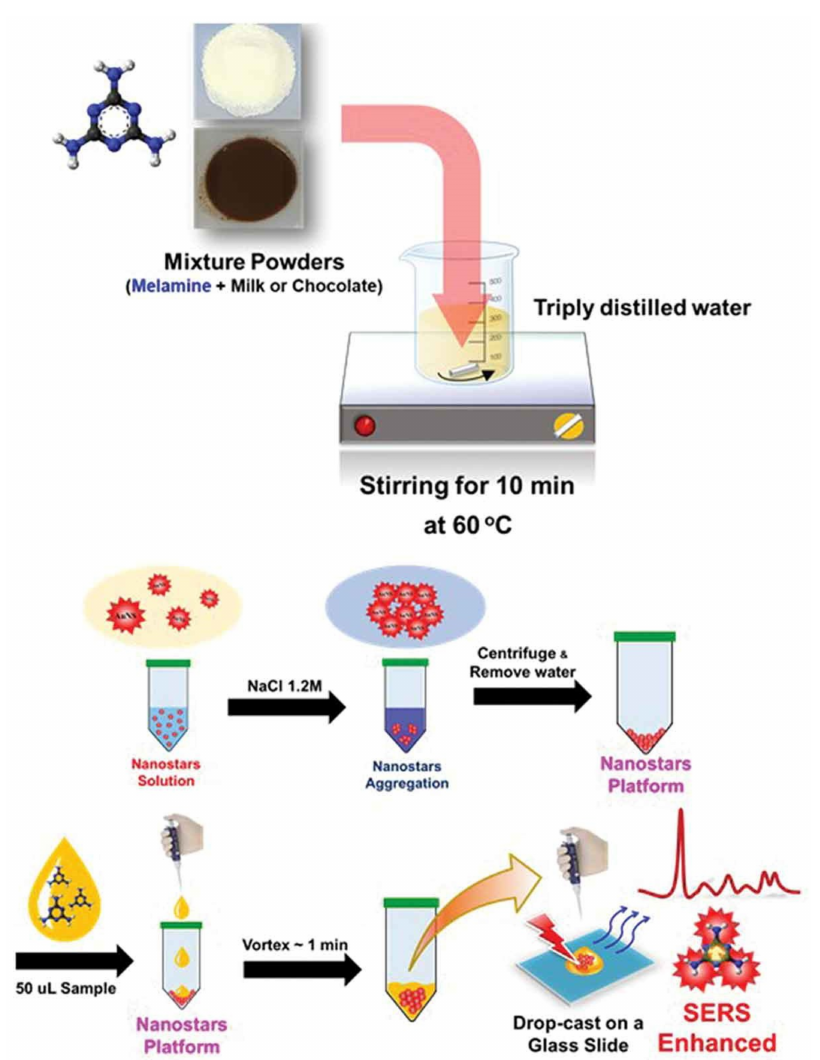
Figure 23. Experimental schemes for detecting melamine in powdered infant formula and chocolate. On-site detection of sub-mg/kg melamine could be achieved using Raman spectroscopy within a few minutes (reproduced with permission from Reference